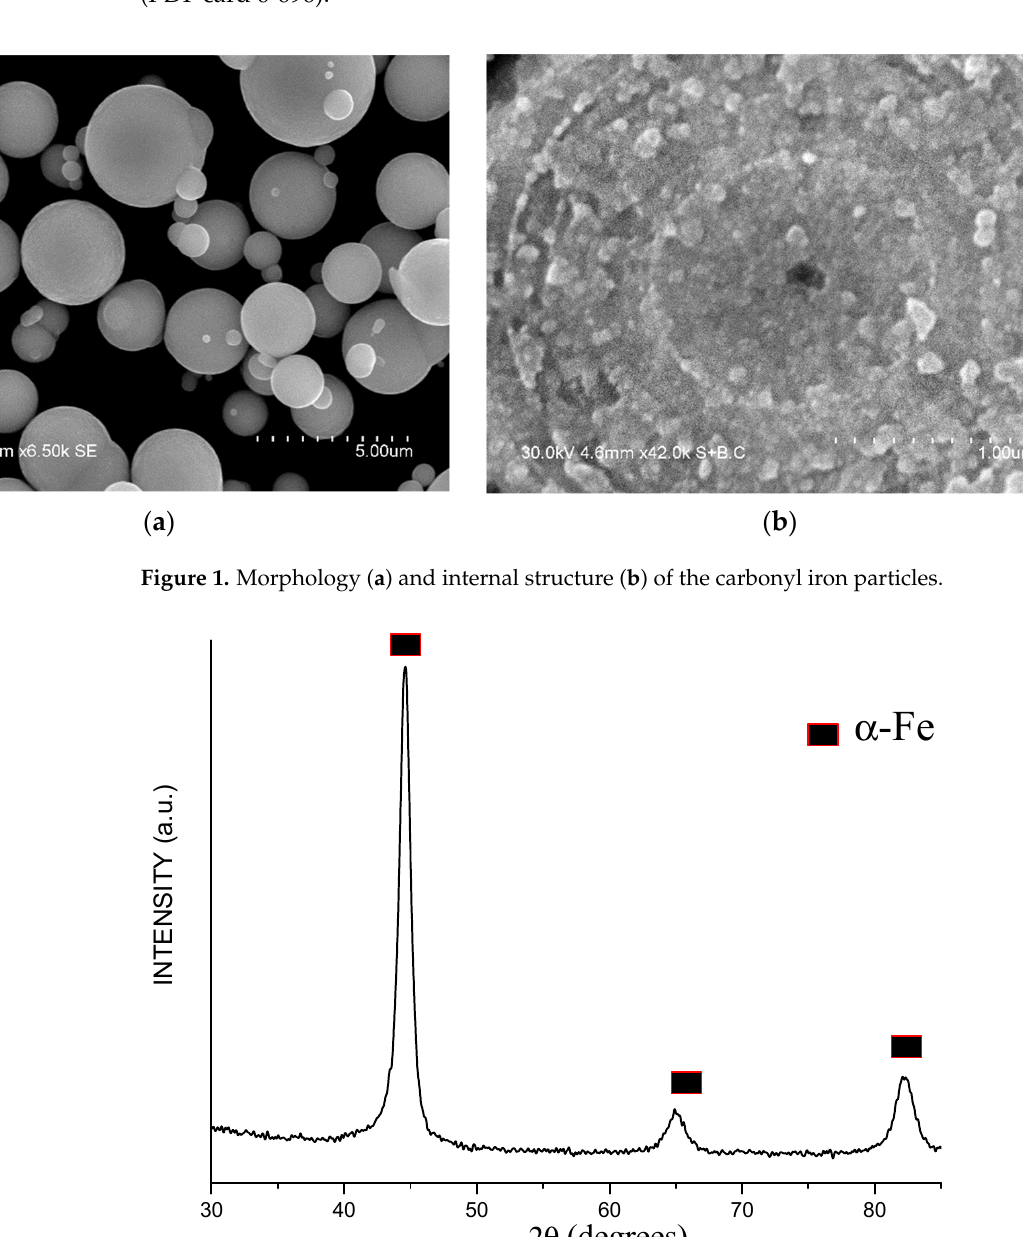
Figure 2. X-ray diffraction (XRD) pattern of the carbonyl iron powder.